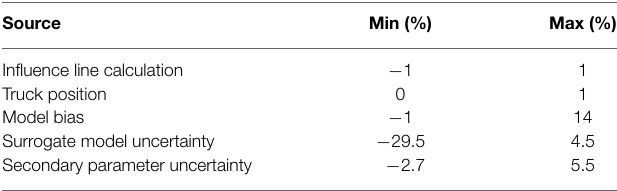
TABLE 5 | Sources of relative prediction